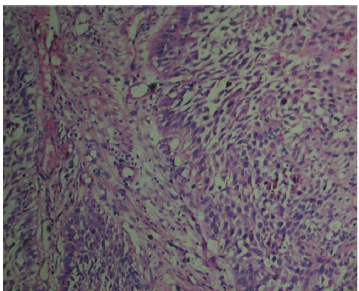
Figure 2: Vimentin expression in the cytoplasm of squamous cell carcinoma (Org. Mag. ×